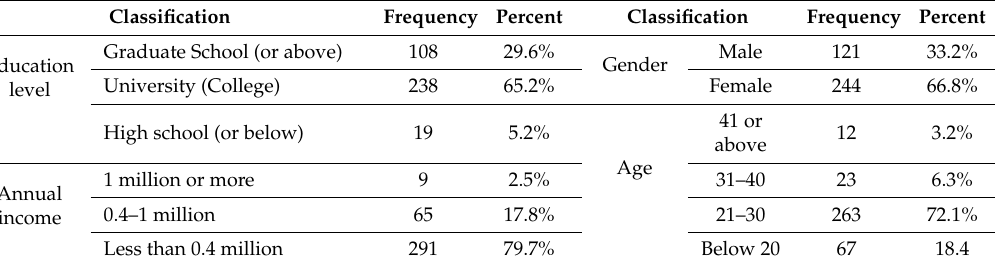
Table 1. Sample distribution by